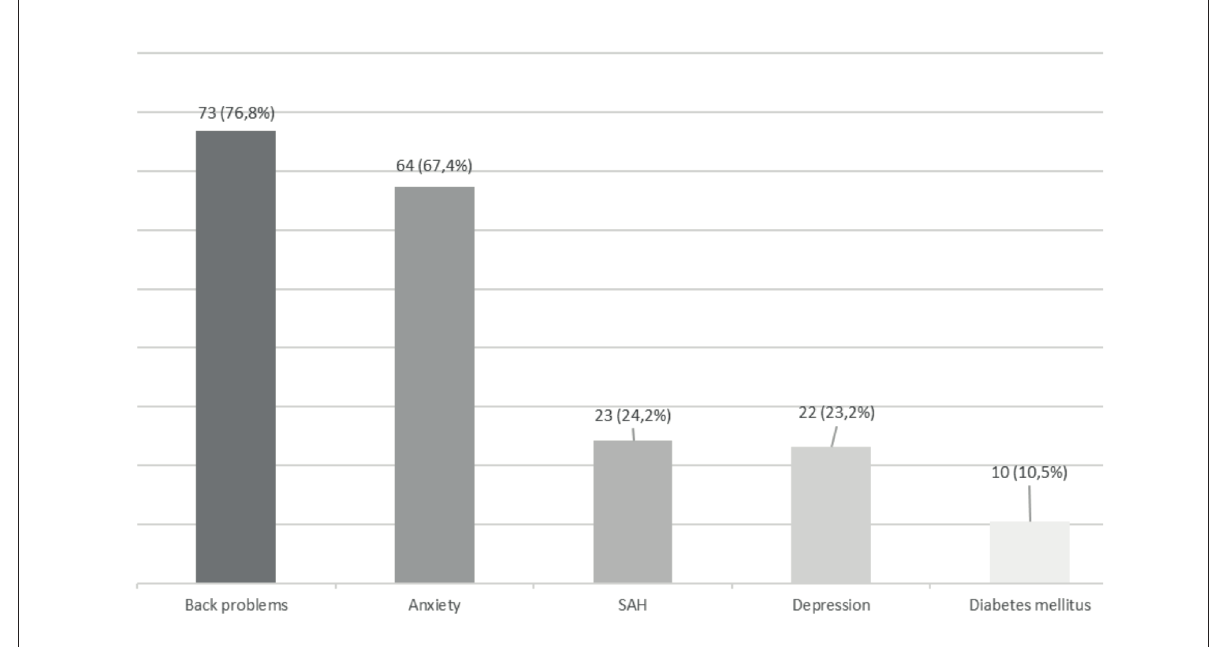
Figure 1 - Distribution of health problems presented by the caregivers of the Home Care Service. Goiânia - GO, 2013. Note: Survey